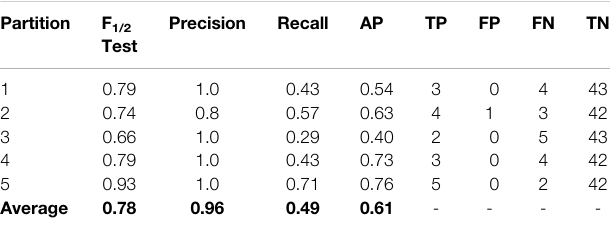
Table 8 , together with their actual placental transfer class (C or NC).